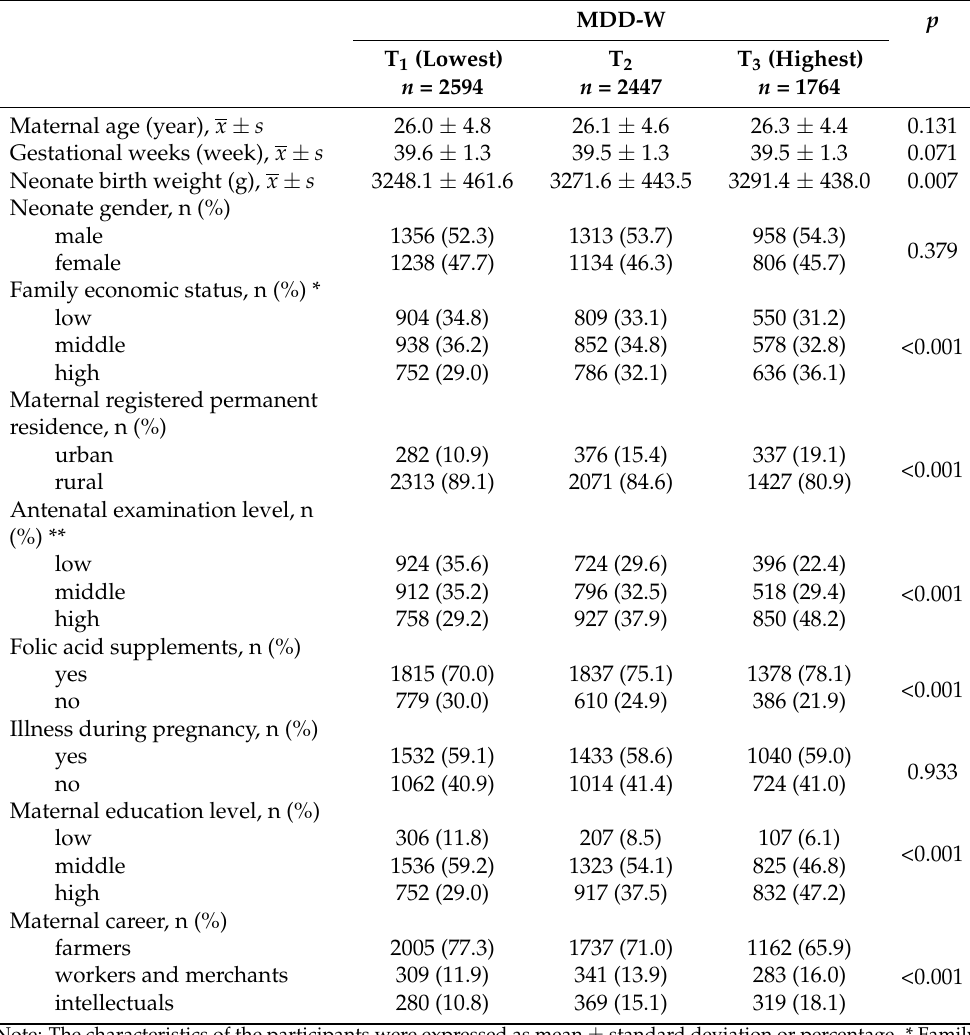
Table 1. The characteristics of the participants according to tertiles of MDD-W